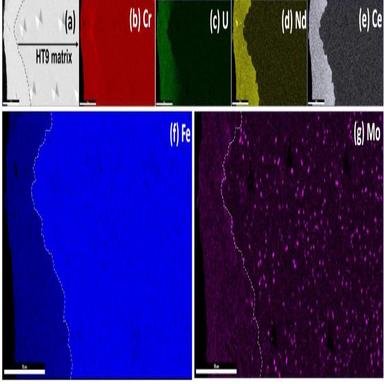
SEM image and EDS mapping showing the microstructure and composition of a selected region with observable Mo-contained particles over the HT9 matrix. Scale bars of 50 μm are shown. (a) shows a SEM image of the selected area. (b)–(g) shows the raw intensity map of individual elements Cr, U, Nd, Ce, Fe, and Mo, respectively. The mapping of Fe and Mo were purposely enlarged for better visualization of precipitated particles.